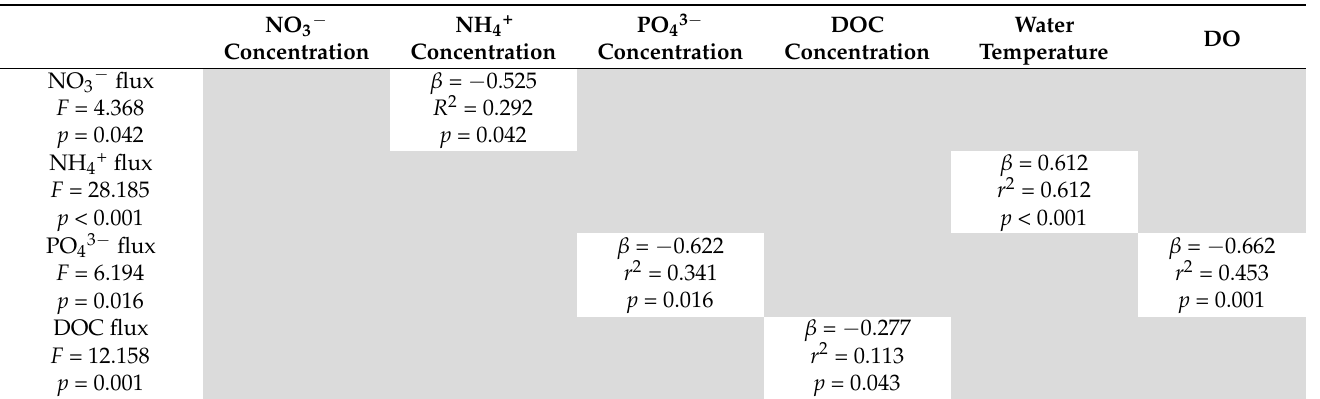
Table 2. Stepwise regression (forward selection) for each nutrient fluxes with nutrient concentrations and water